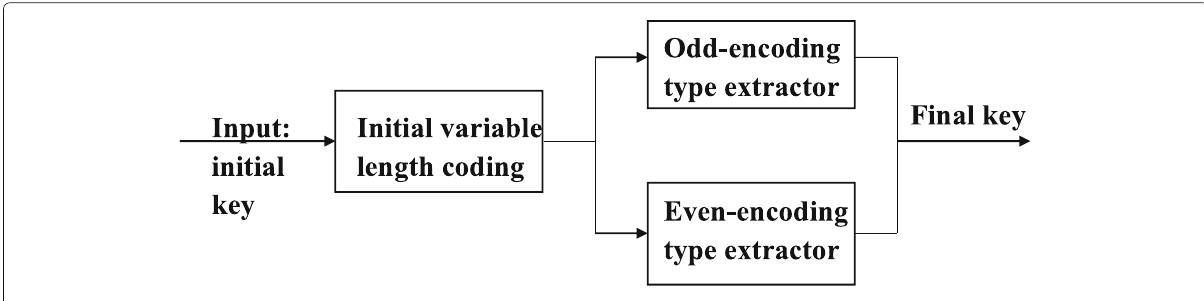
Fig. 8 Randomness